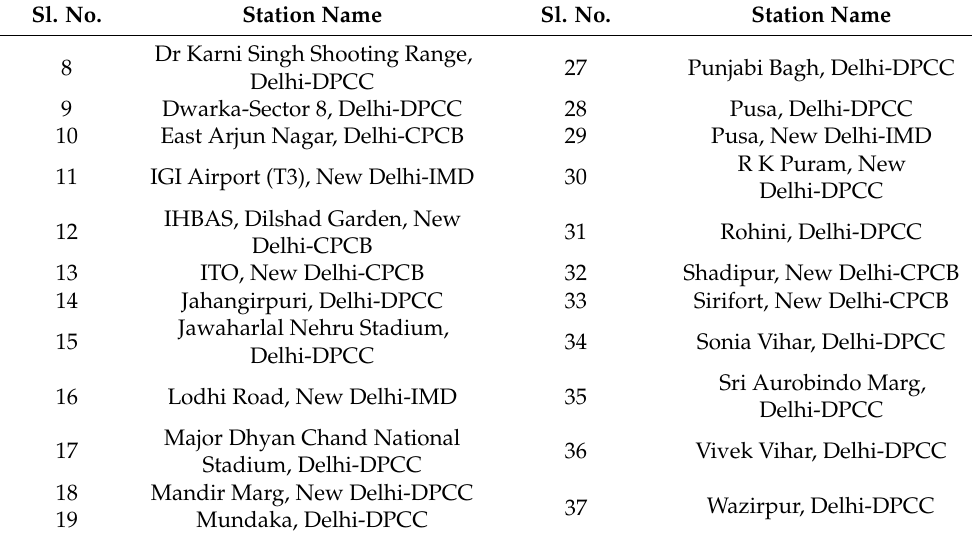
Table 1. Cont. Sl.